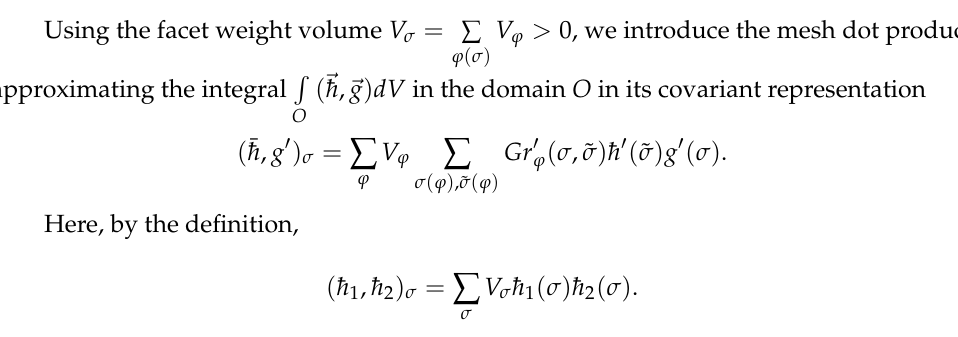
Figure 1. Mesh and mesh bases: ( a ) tetrahedron; ( b ) boundary approximation of the Poynting flux; ( c ) magnetic circulation on the boundary contour the cell ∂ Ω is